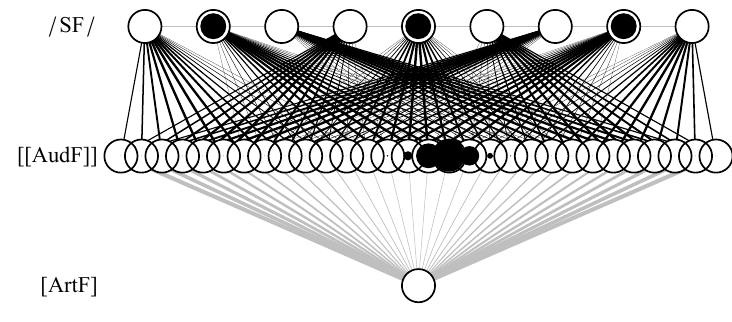
Figure 25: The neural network